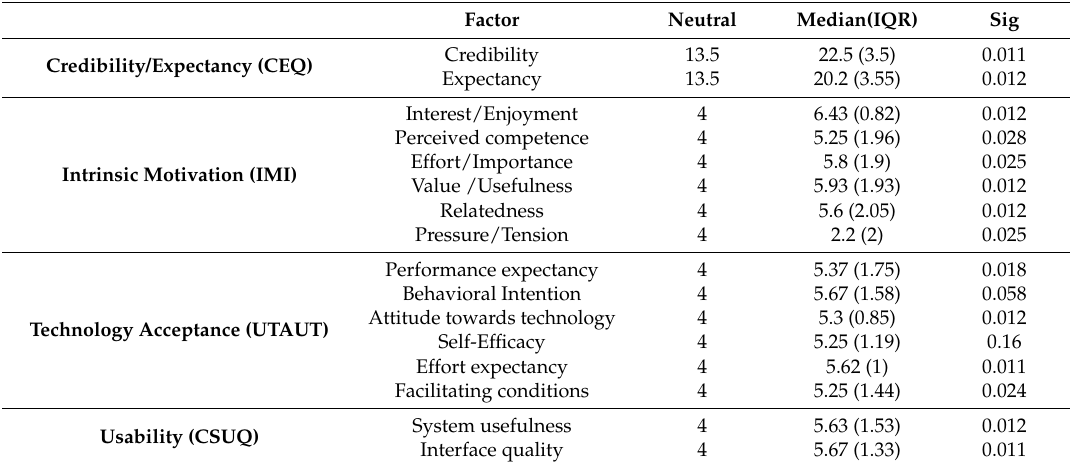
Table 1. Overview of system